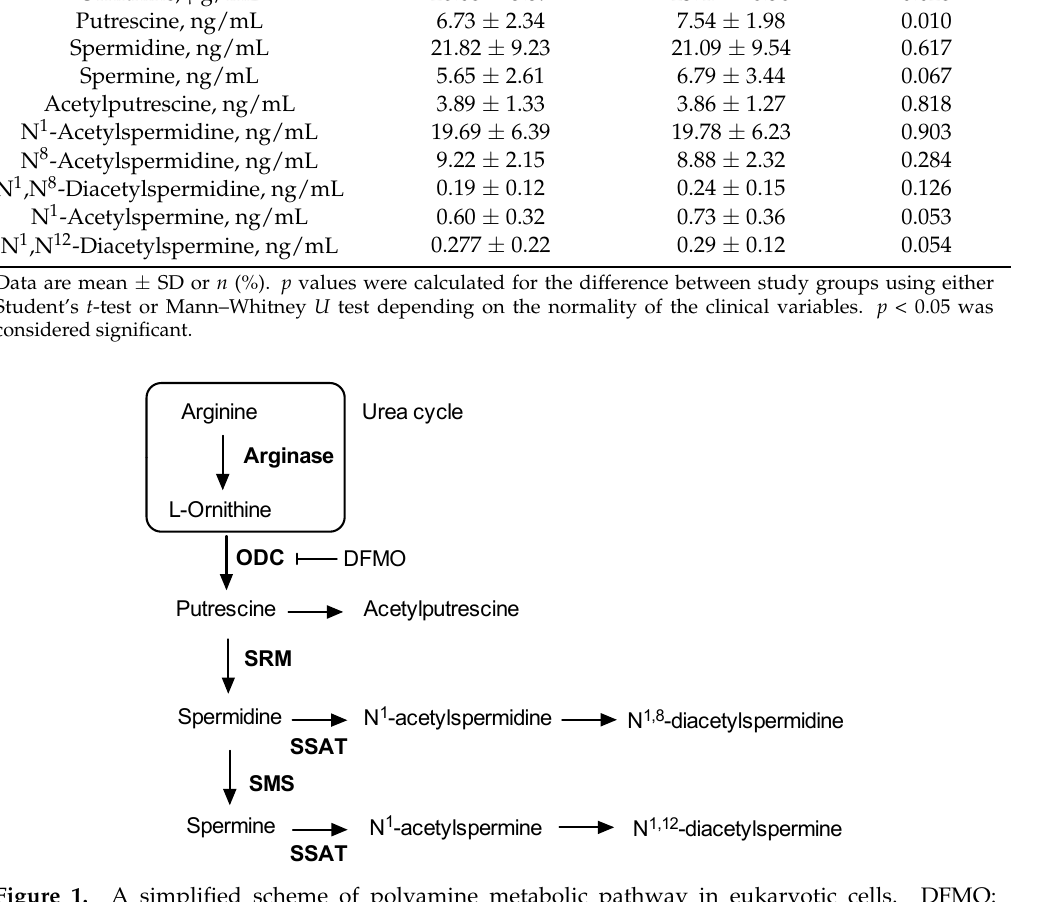
Figure 1. A simplified scheme of polyamine metabolic pathway in eukaryotic cells. DFMO: difluoromethylornithine; ODC: ornithine decarboxylase; SMS: spermine synthase; SRM: spermidine synthase; SSAT: spermidine/spermine acetyltransferase.